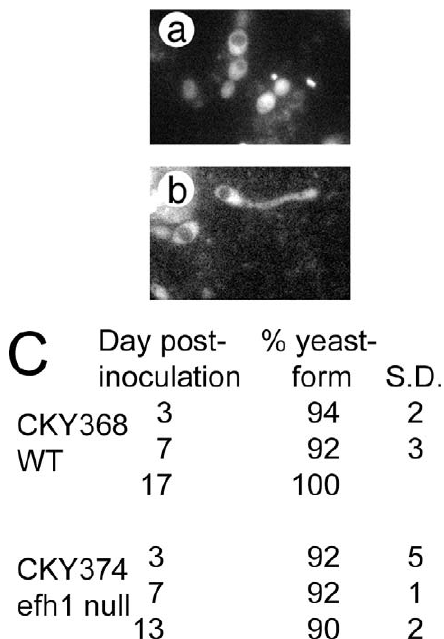
Figure 2. C. albicans Cells Colonizing the Murine Intestinal Tract Are Predominantly in the Yeast Form (A and B) Contents of the ileum of mice inoculated with C. albicans strain CKY368, WT, GFP-expressing, day 3 post-inoculation (A) or strain CKY374, efh1 null mutant, GFP-expressing day 13, post-inoculation (B). Fluo- rescence micrographs show the morphology of yeast-form cells (A) or hyphal-form cells (B). (C) Quantitation of cellular